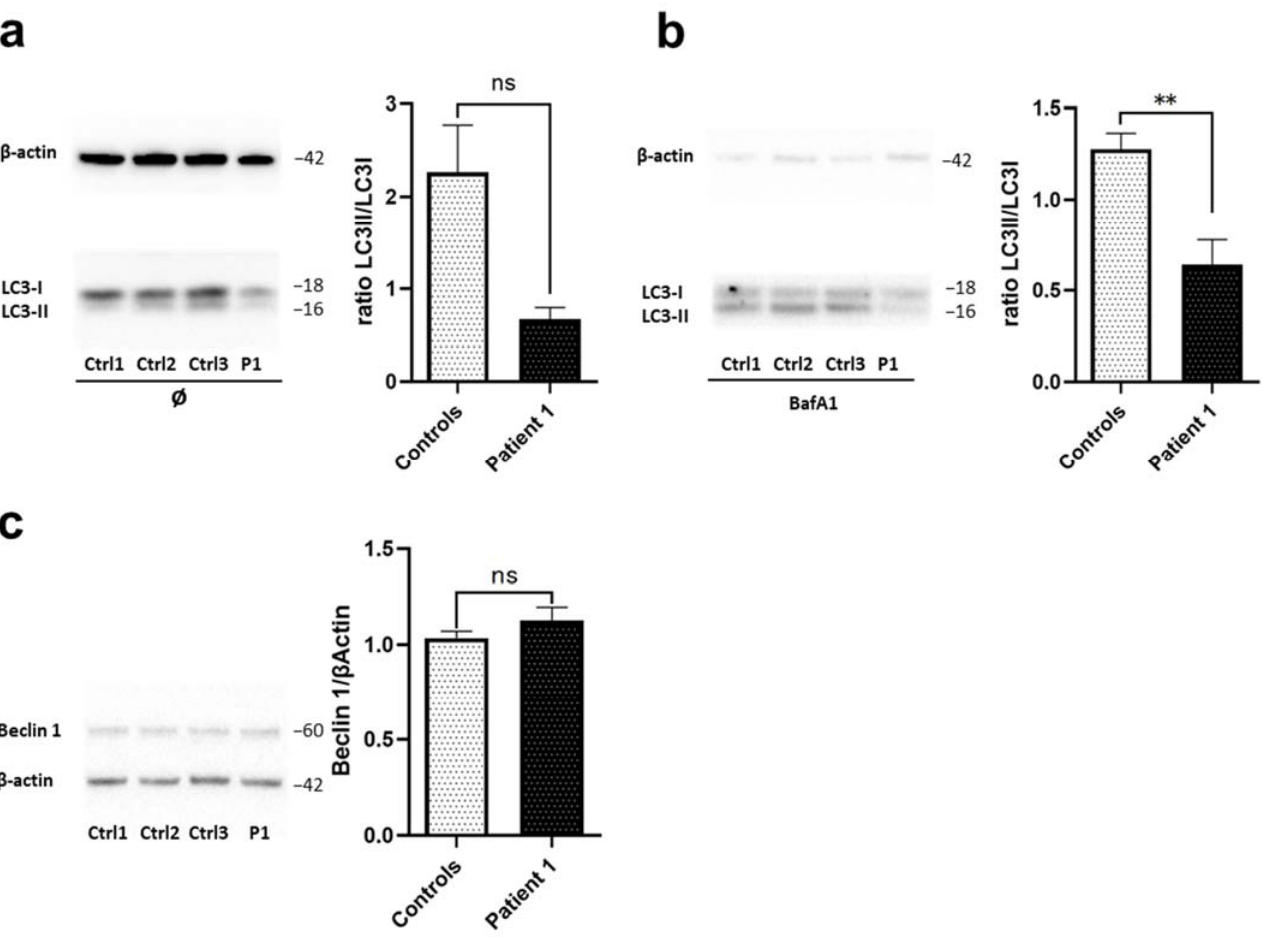
Figure 3. WDR45 -mutant fibroblasts exhibit altered autophagy. Western blot analysis of total protein extract from fibroblasts from: ( a ) WDR45 mutation carrier (P1-Patient 1) and three healthy controls (Ctrl1, Ctrl2, Ctrl3) with antibody against the autophagosome marker LC3-II (membrane- bound form), and β -actin (loading control) under basal conditions, ( b ) and upon treatment with 10 nM of Bafilomycin A1 for 6 h. ( c ) Patient 1’s fibroblasts (P1) and three healthy controls (Ctrl1, Ctrl2, Ctrl3) with antibodies against Beclin 1 and β -actin (loading control). Data analysis was carried out for all Western Blots with Ctrl1 set as 1. The error bars indicate the standard error of the mean of n ≥ 3 independent experiments. Statistical significance was analyzed by Unpaired t ‐ test (ns refers to p ≥ 0.05; ** p < 0.01).